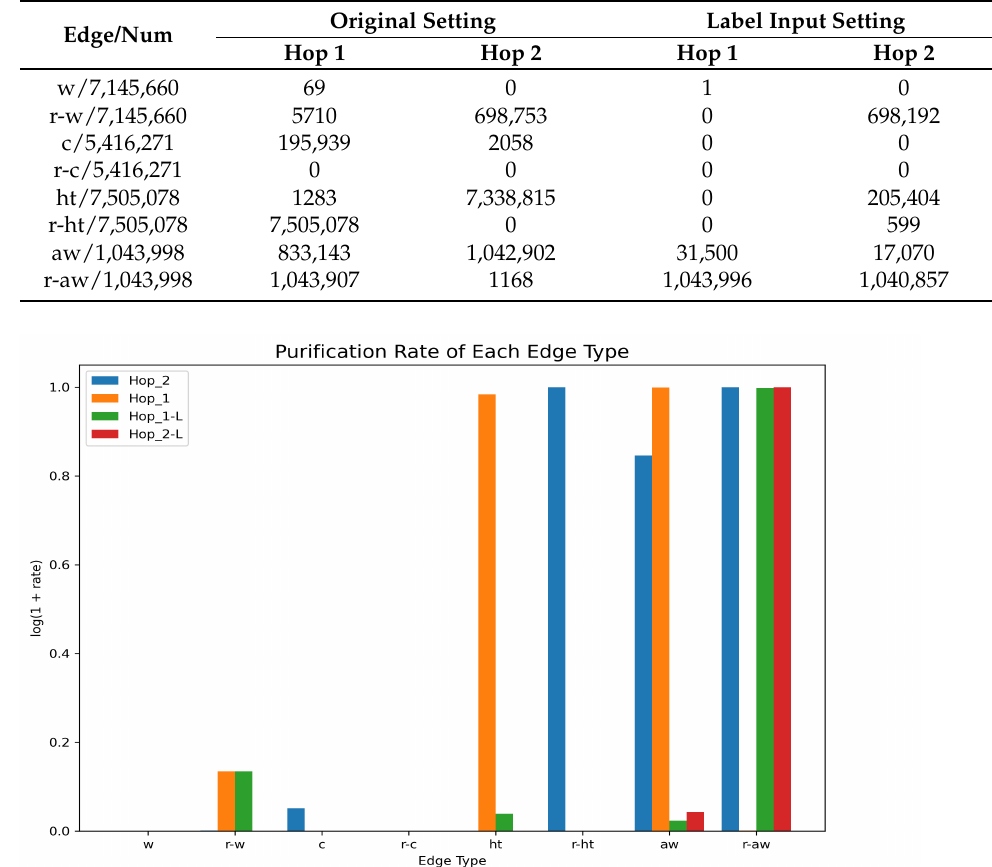
Figure 3. Purification rate of each edge type on OGB-MAG under 2 training settings. “w” means “writes”, “c” means “cites”, “ht” means “has topic”, “aw” means “affiliated with”. “r-x” means the reverse type of edge type “x”. “Hop_i” denotes neighbours from i-th hop, and “Hop_i-L” denotes “Hop_i” with the training setting of “Label